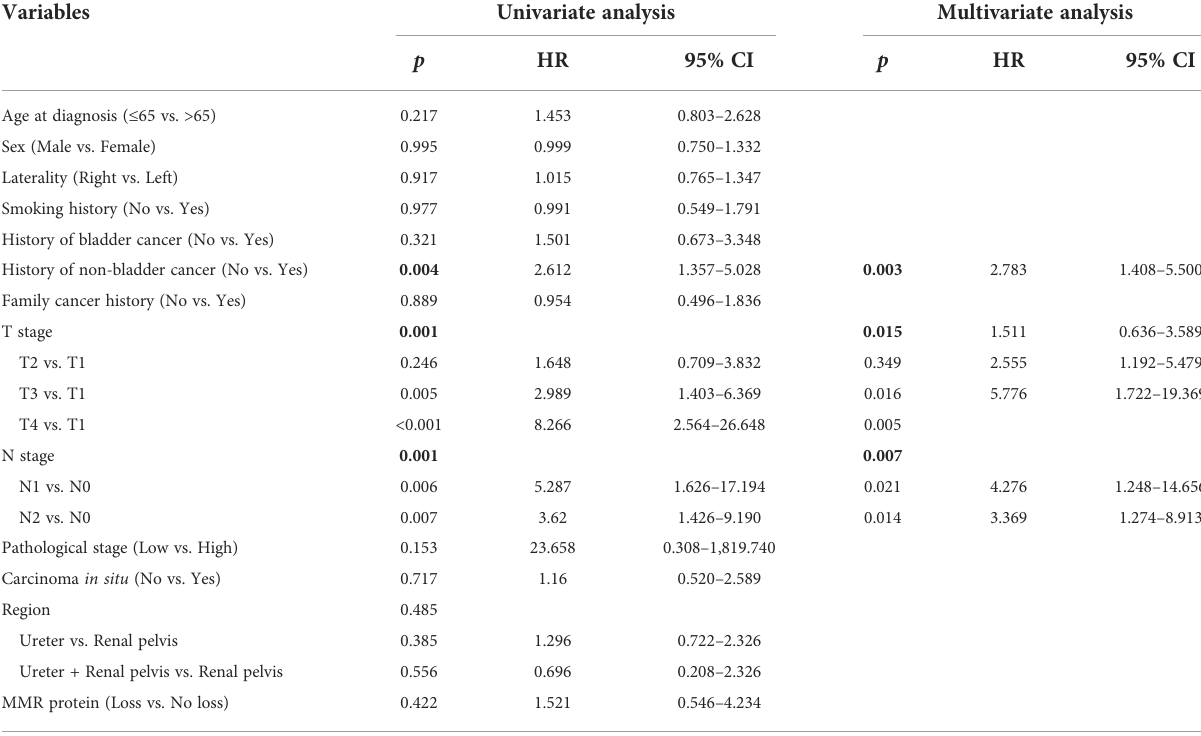
TABLE 3 Univariate and multivariate Cox regression analysis: relapse-free survival in upper urinary tract urothelial carcinoma.